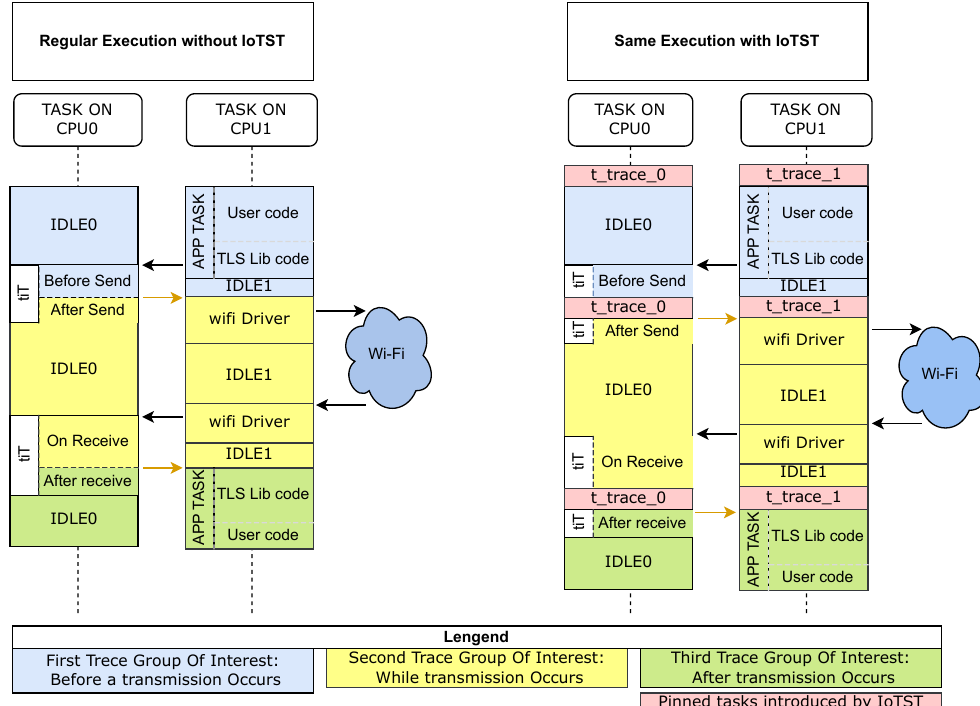
Figure 6. Regular execution and the same execution with the use of